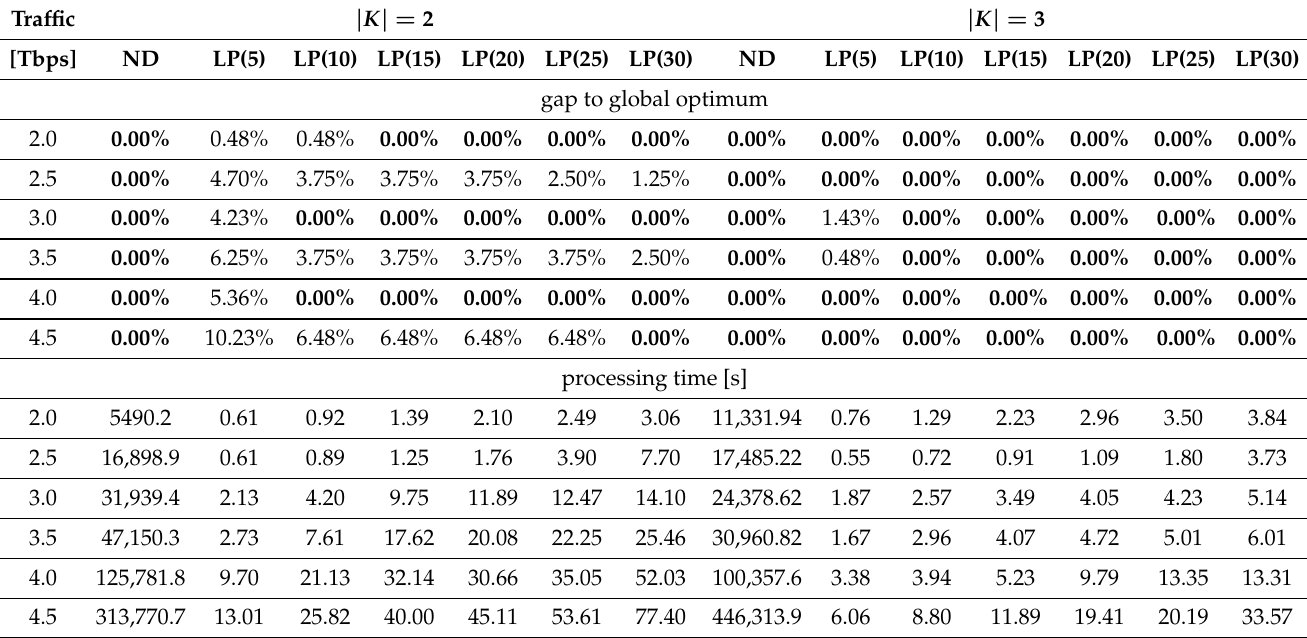
Table 4. Comparison of the node-link and the link-path models for the network planning problem and PL12—the average gap to global optimum [%] and the processing time [s] (for each | K | value and traffic volume, the best result is bold).